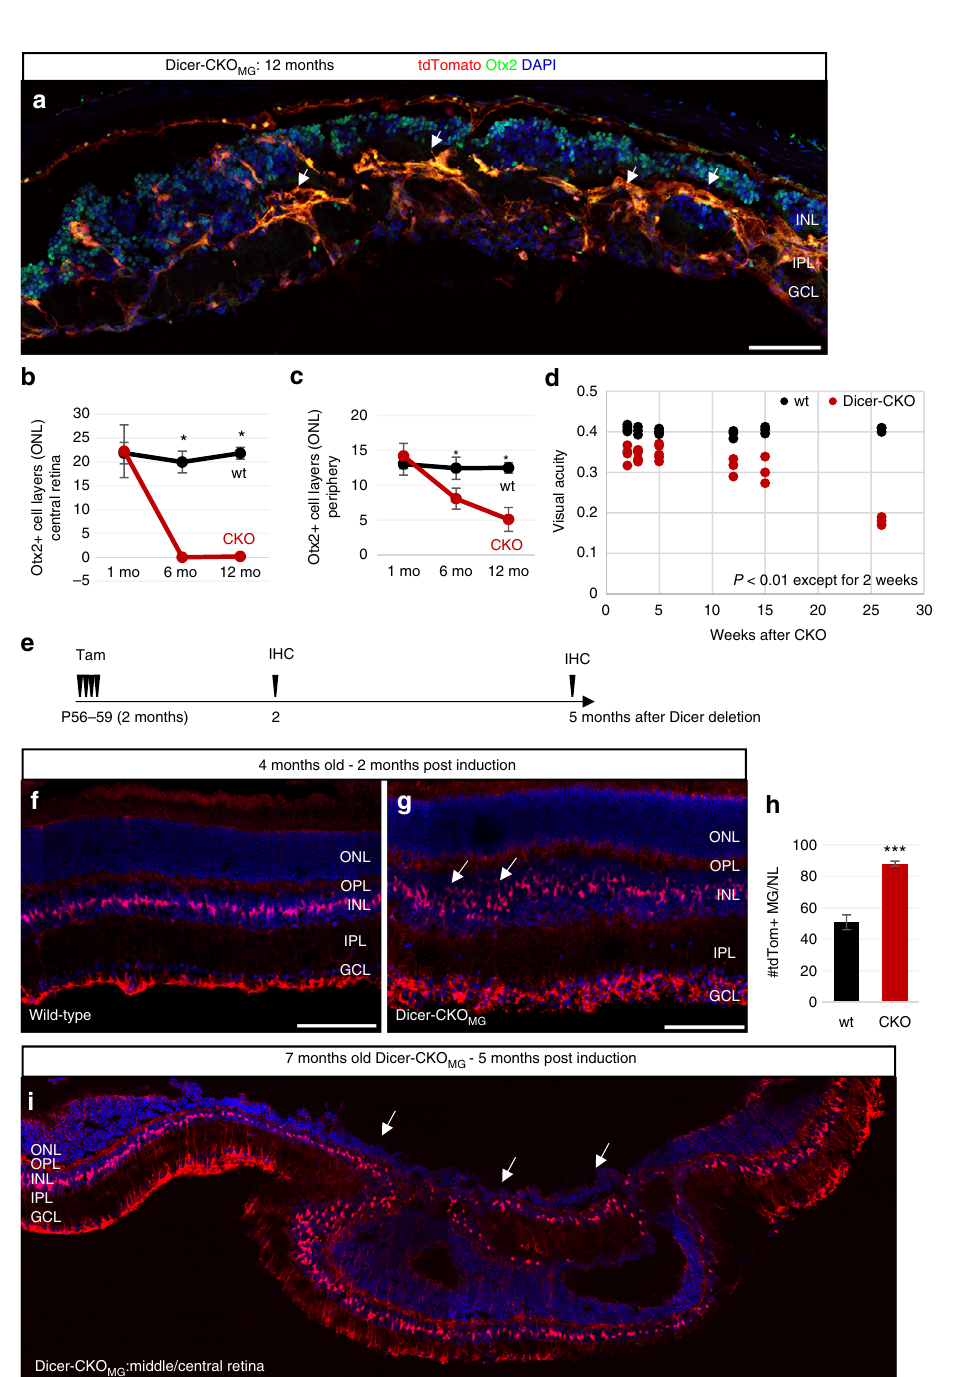
Fig. 3 Disruption of retinal structure and function after Dicer1 deletion in MG in either juvenile or adult mice. a Immuno fl uorescence for tdTomato (endogenous, unlabeled), Otx2, and DAPI of retinal cross sections of an adult Dicer-CKO MG mouse 12 months after Dicer1 deletion, which